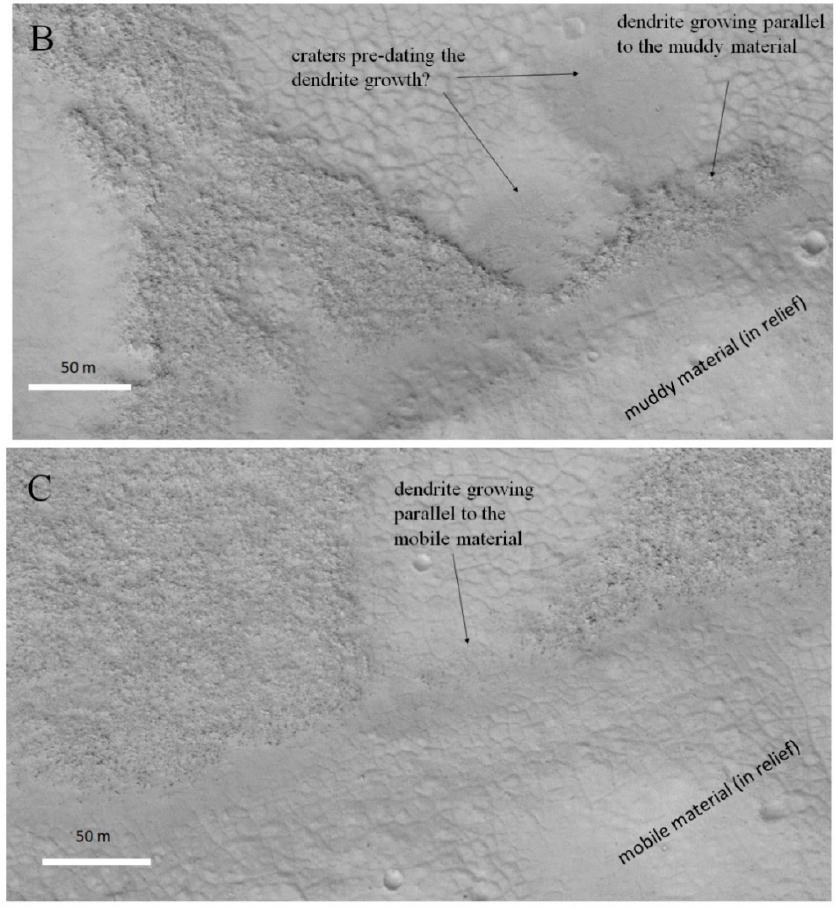
Figure 11. ( A ) HiRISE details of dendrite growth parallel to the mobile material. The area examined is highlighted in Figure 10. ( B , C ) Details of growth along the deposit of mobile material, probably consisting of lake mud.